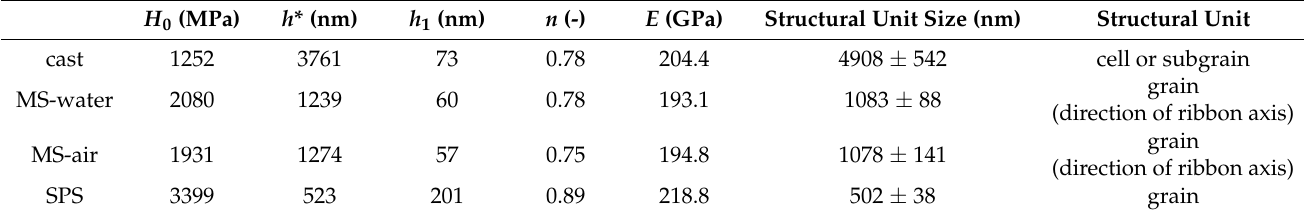
Figure 4. ( a ) Indentation force–depth curves; ( b ) hardness as a function of indentation depth of CoCrFeMnNi samples.